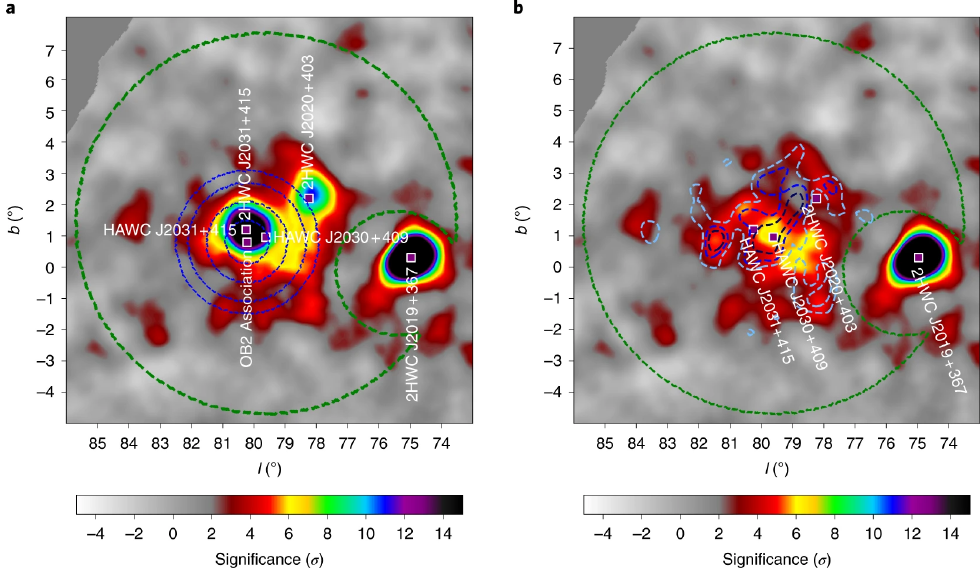
Figure 9. ( a ) Significance map of the Cocoon region before, and subtraction of the known sources in Galactic coordinates, latitude, b, and longitude, l. The blue contours are four annuli centered at the OB2 association, where the CR density was estimated. The green contour is the ROI used for the study, which masks the bright source 2HWC J2019+367. ( b ) Significance map of the Cocoon region after subtracting HAWC J2031+415 (PWN) and 2HWC J2020+403 ( γ -Cygni). The light-blue, medium-blue, and dark-blue dashed lines are contours for 0.16, 0.24, and 0.32 photons per 0.1 deg × 0.1 deg spatial bin, respectively, from Fermi-LAT Cocoon. Figures from